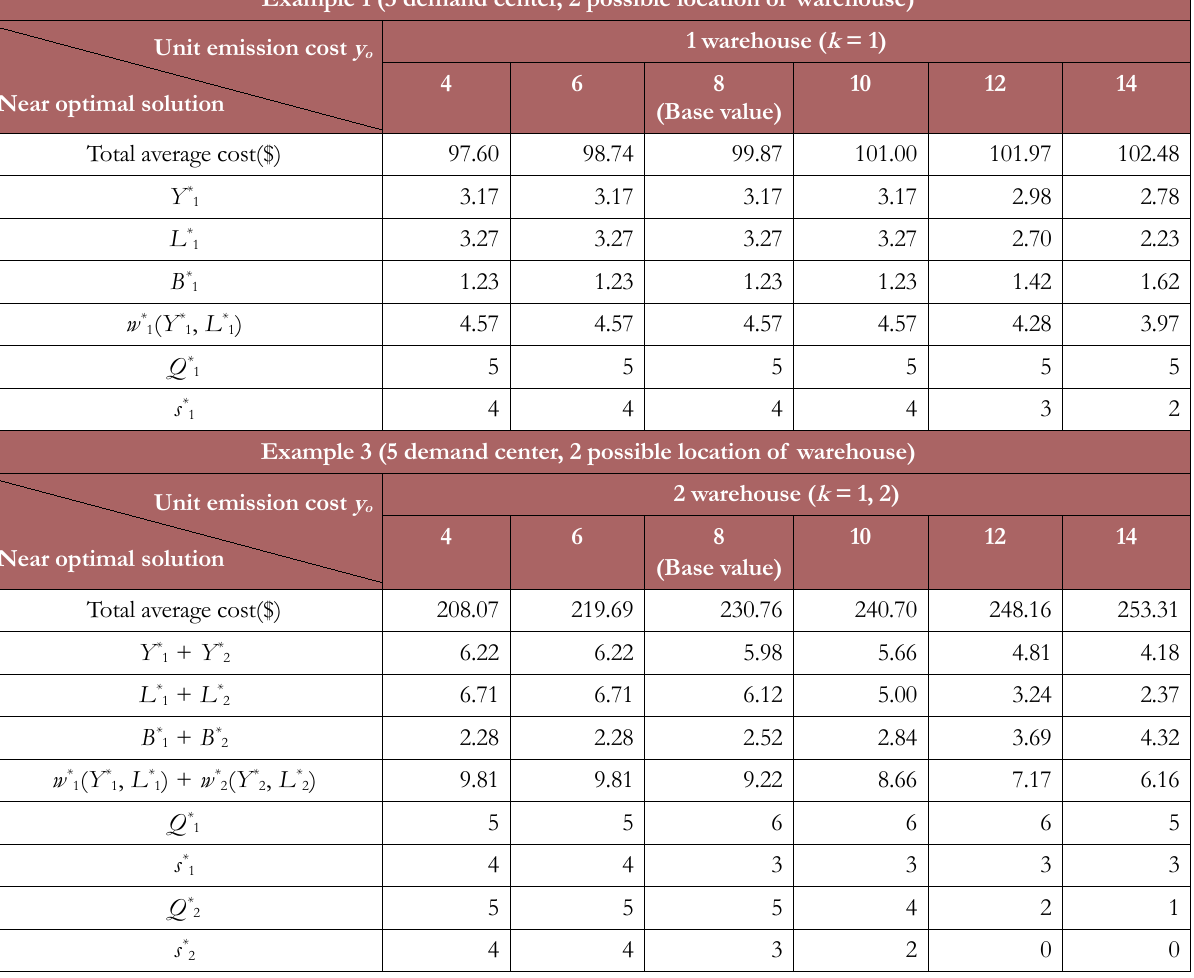
Table 9. Impact of the unit emission